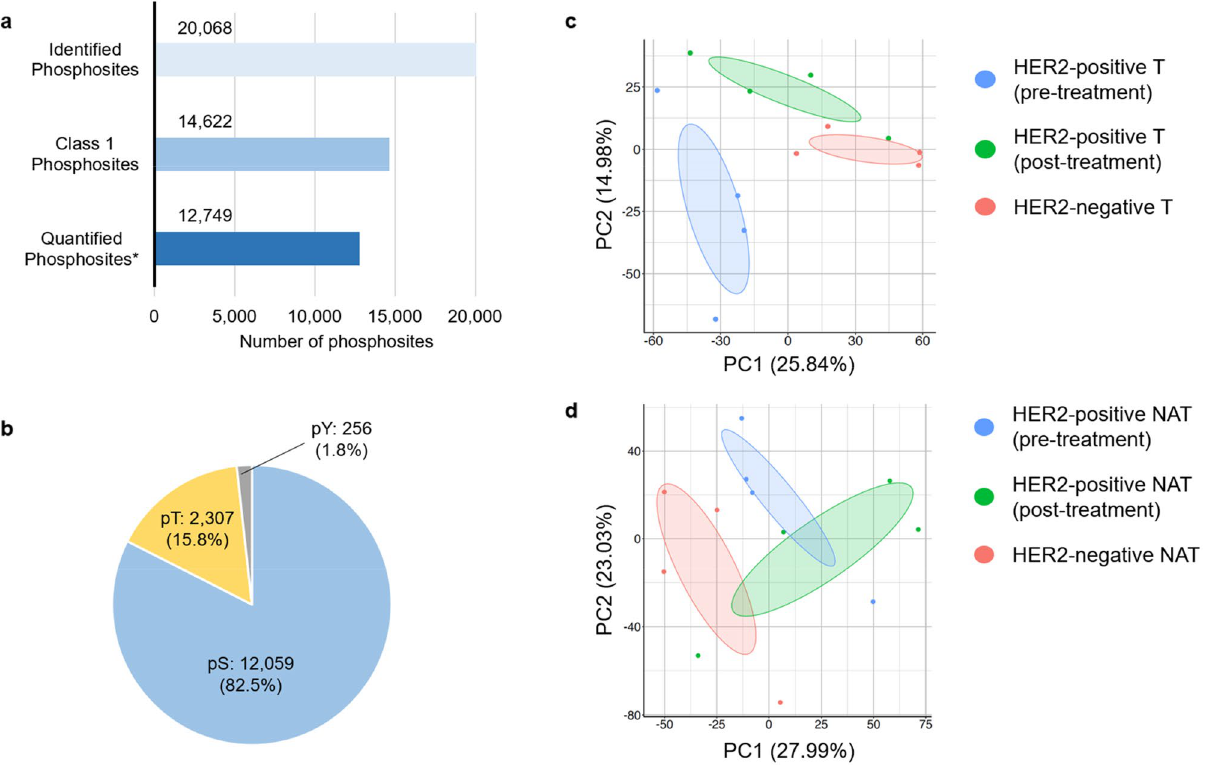
Figure 2. Summary of the results of phosphoproteomic analysis. ( a ) Number of identified phosphosites, class 1 phosphosites, quantified class 1 phosphosites. Asterisk (quantified phosphosites) means the phosphosites with quantitative values in at least one sample. ( b ) The proportions of phospho-serine (pS, blue), phospho- threonine (pT, yellow), phospho-tyrosine (pY, grey). ( c ) Principal component analysis of tumor samples using phosphoproteomic data. ( d ) Principal component analysis of non-tumor adjacent samples using phosphoproteomic